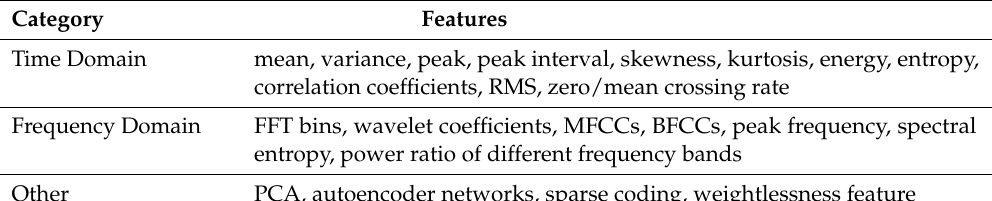
Table 2. Feature categorization of walk detection (WD) and step counting (SC). BFCC, Bark-frequency cepstral